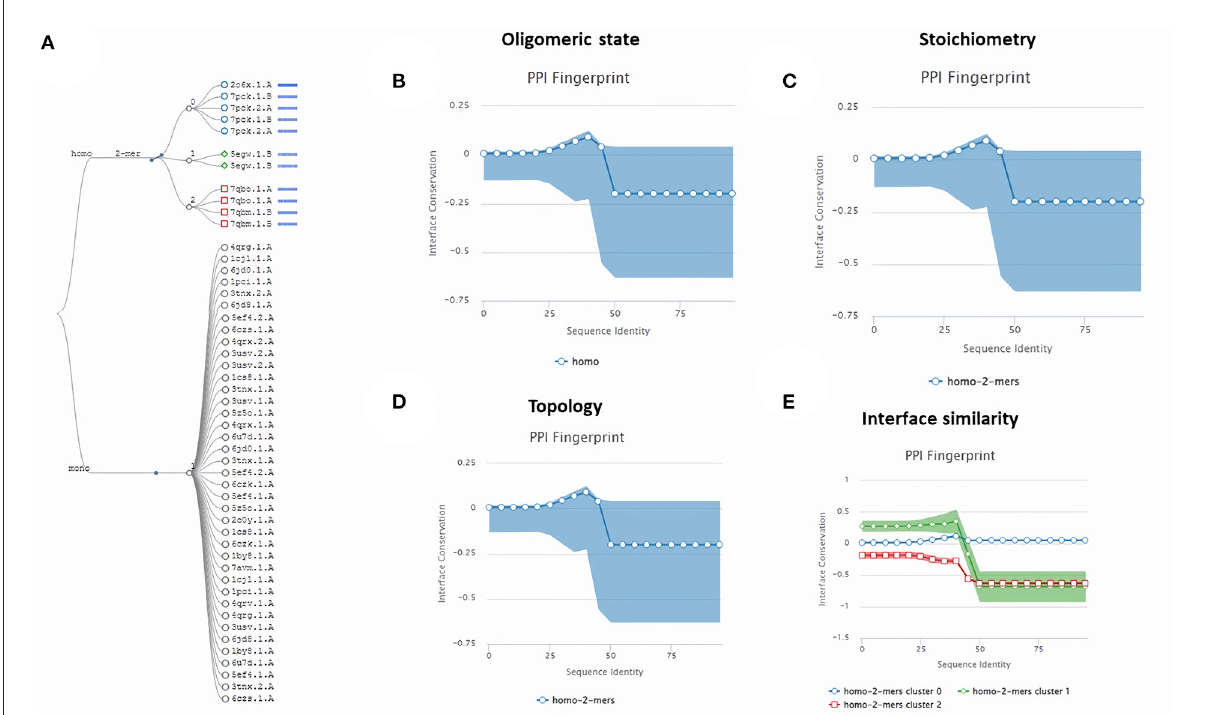
FIGURE5 Quaternary structure analysis of FhCatL1 as a homo-dimer model (A) Structural clustering tree of FhCatL1 homologs with known structure. Each leaf is a template labeled with the PDB code and a bar indicating sequence identity and coverage (darker shades of blue refer to higher sequence identity). The decision tree follows the described levels of clustering: oligomeric state (B) , stoichiometry (C) , the topology of the complexes (D) , and interface similarity (E) . The PPI fingerprint curves of our oligo-dimeric target shows high consistency with PDB model code 206X with high consistency as shown oligomeric state, stoichiometry and topological characteristics. Also, our homo-dimer target showed a higher similarity for interface interactions with cluster 0 (blue circle) included 206X than cluster 1 (green rhomboid) and 2 (red